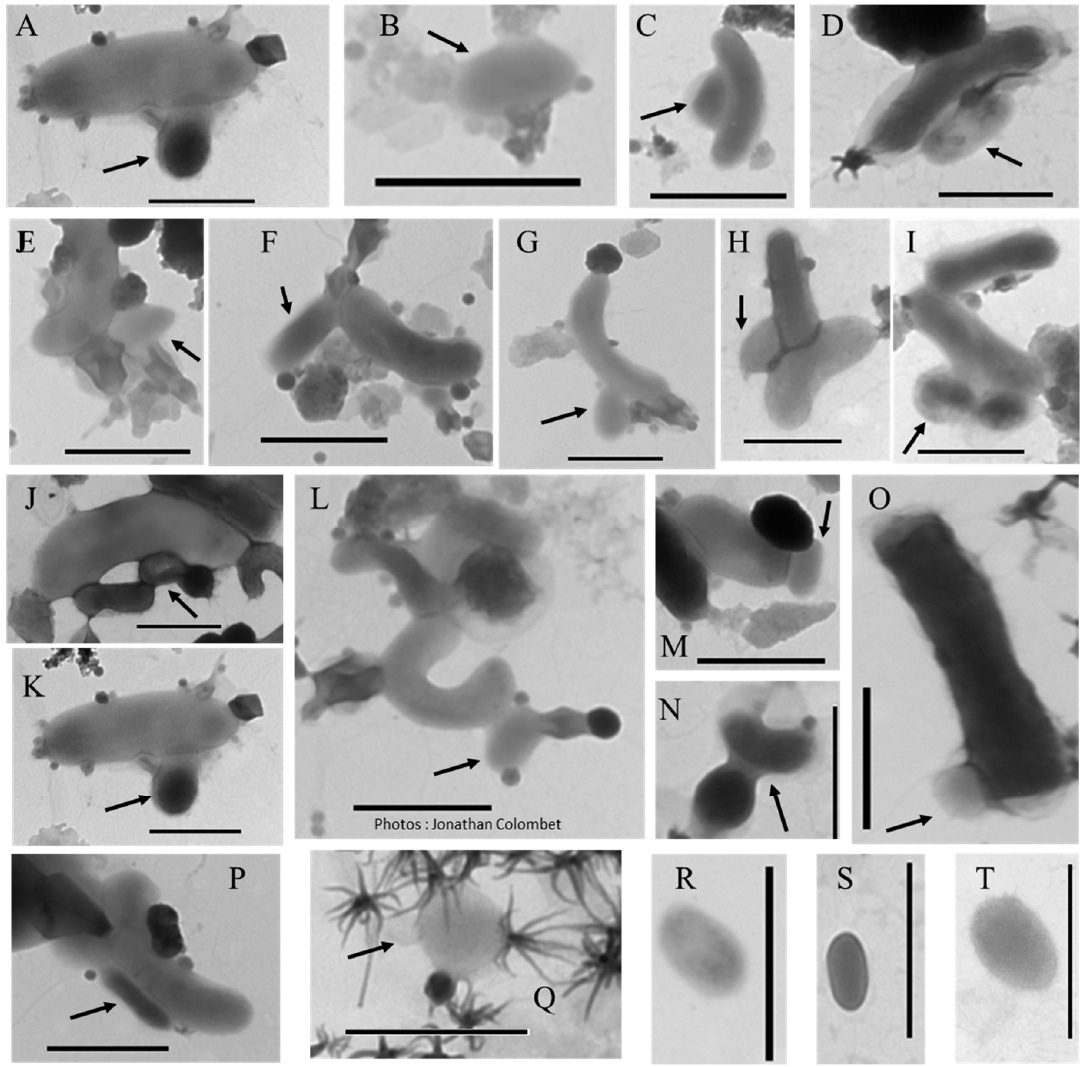
Figure 4. Transmission electron micrographs of attached ( A – Q ) or free ( R – T ) femtoplankton-like prokaryotes. Arrows indicate the target particles when the samples are heterogeneous. Scale bar: 500 nm.